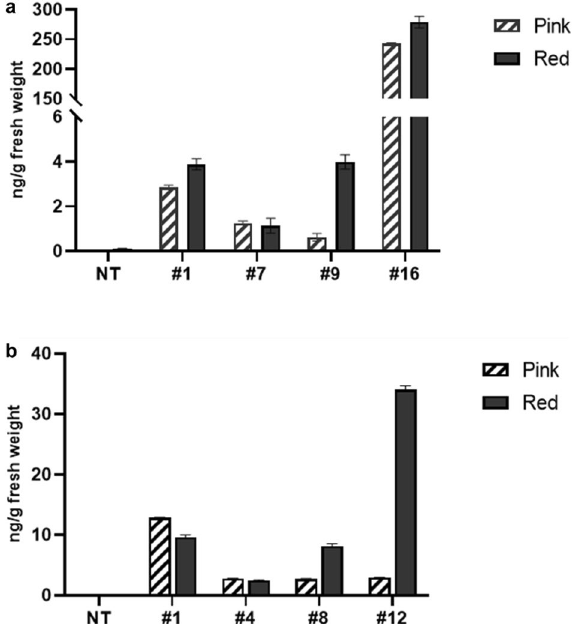
Figure 2. The rGA733-Fc and h-Fc protein expression levels in the transgenic tomato fruits. ELISA analysis was performed to quantify the protein expression level in the pink and red stage of transgenic fruits. ( a ) rGA733-Fc protein levels in fruits of rGA733-Fc OX transgenic plants. ( b ) h-Fc protein levels in fruits of h-Fc OX transgenic plants. Data represent mean + standard deviation (N = 3).